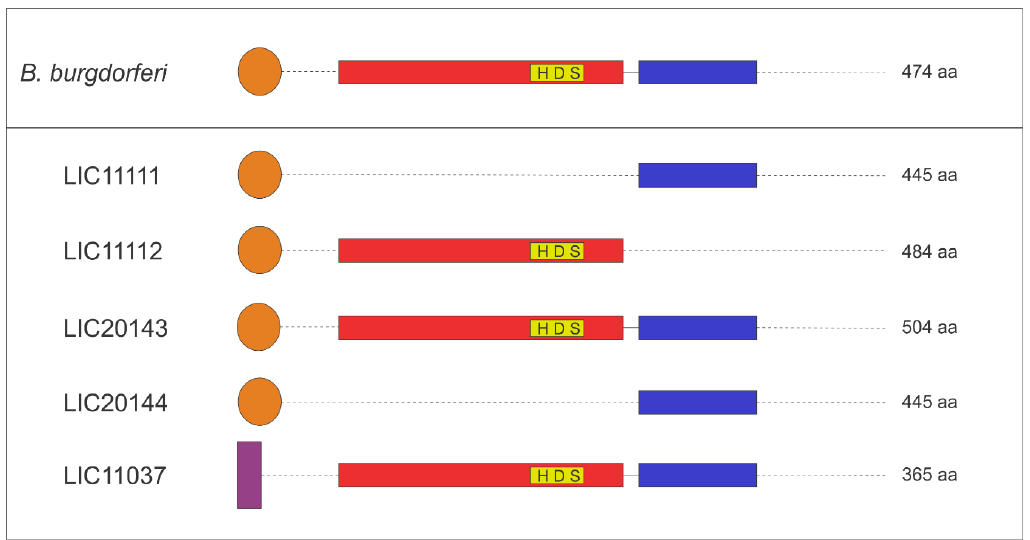
Figure 5. Domain sequence architecture. Schematic representation of the domain organization of the five proteins discussed here. HtrA from B. burgdorferi used as a reference showing the signal peptide, serine protease and PDZ domains, common to this family of proteins. The regions in red represent the serine protease domain, in blue the PDZ domain, in orange the signal peptide region and in purple the transmembrane region. The catalytic triad (histidine, aspartate, and serine; HDS) is in the yellow box.